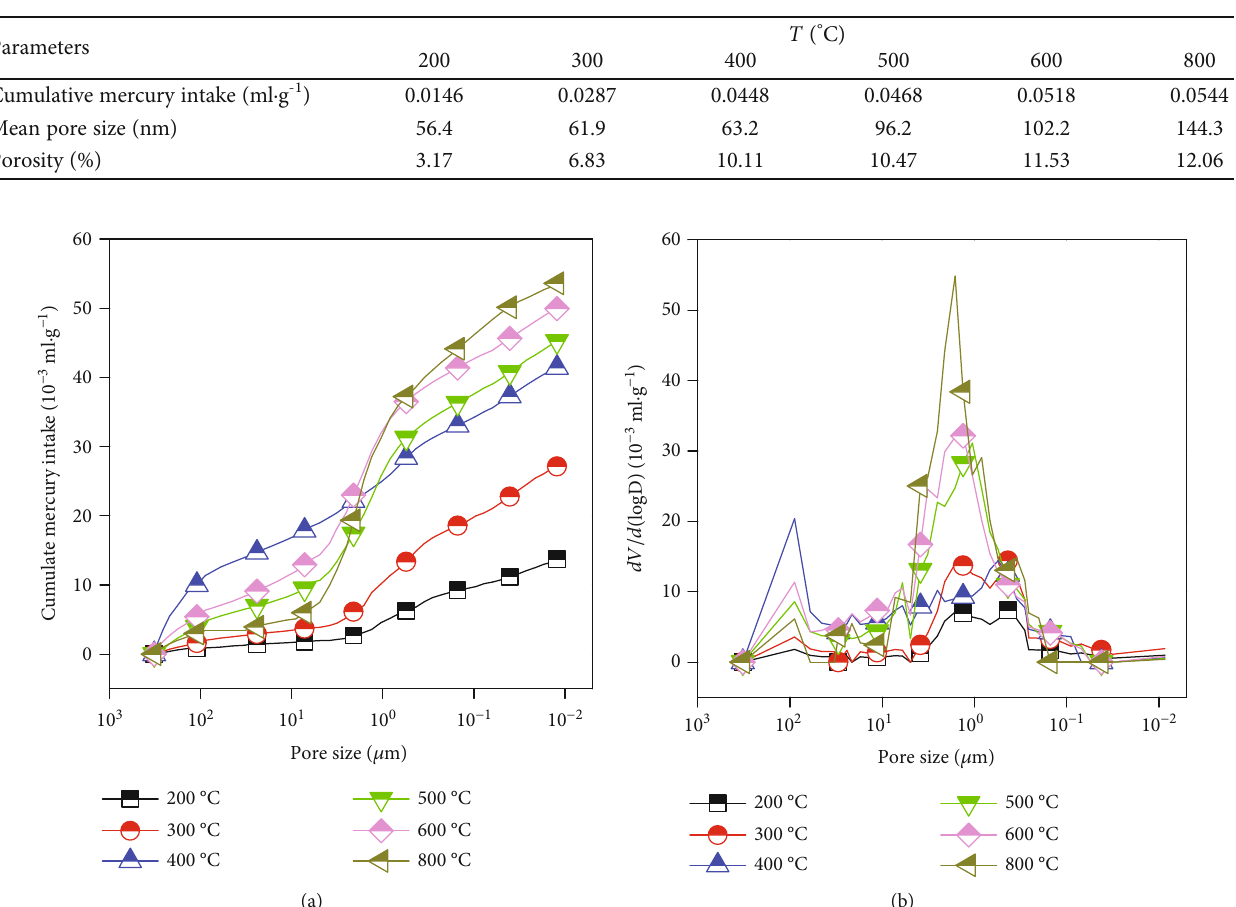
Table 2: Pore structure parameters of heat-treated red sandstone specimens.